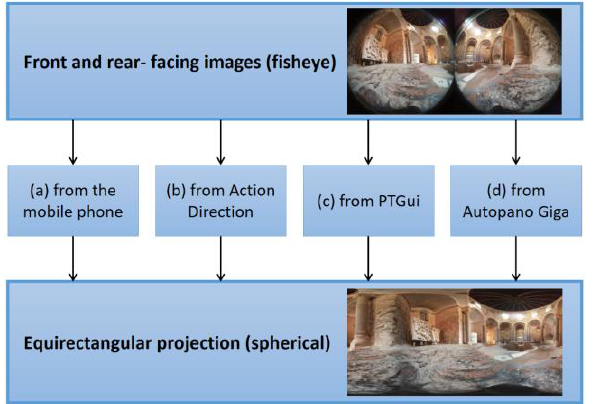
Fig. 2. The different options for the generation of